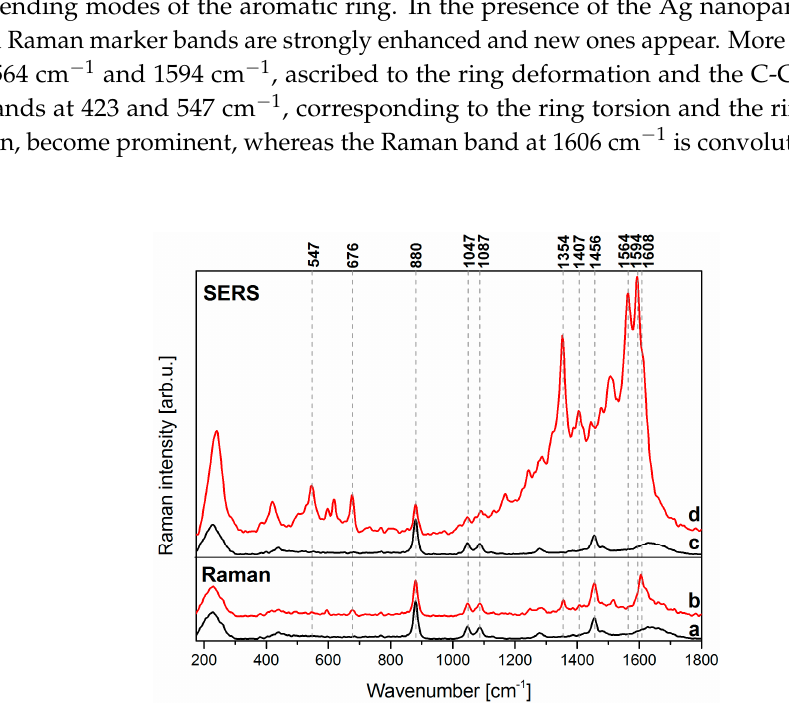
Figure 1. Normalized Raman spectra of 10% ethanol solution (a) and PYO 500 μ M solution (b), as well as normalized SERS spectra of the same ethanol solution (c) and PYO 10 μ M solution (d).